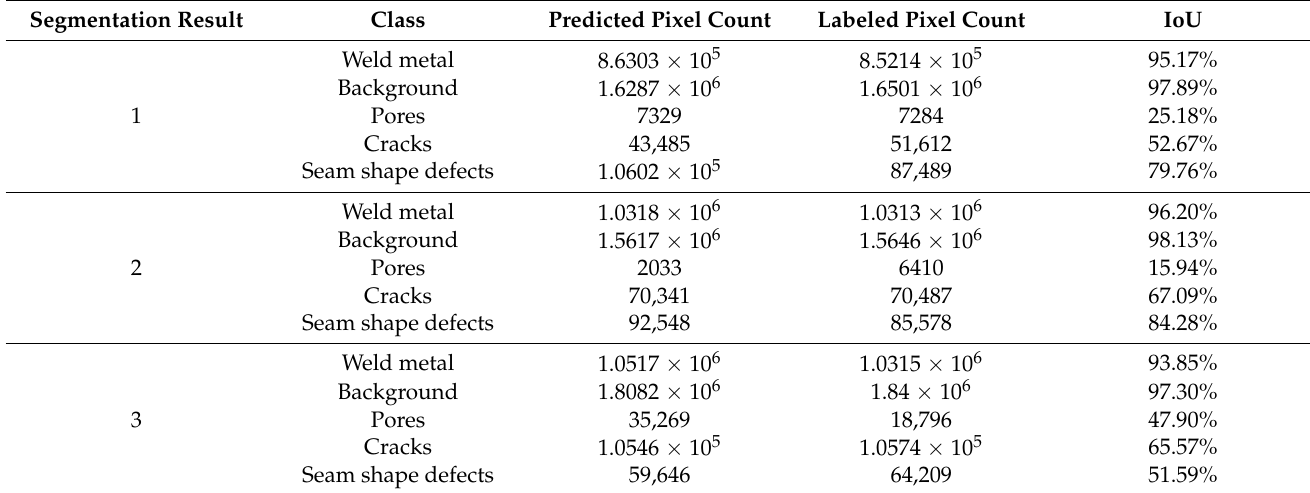
Table 10. Numerical values of segmentation results.